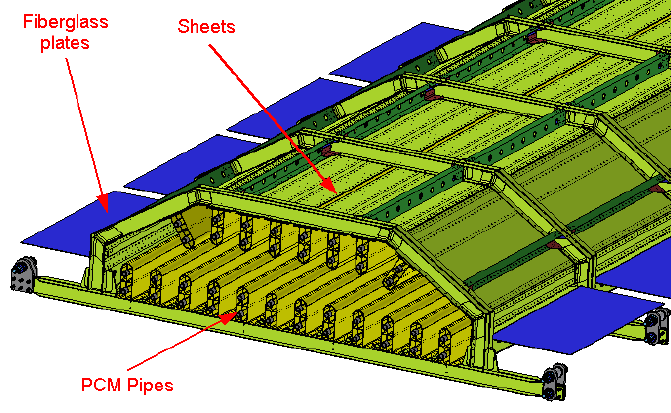
Figure 5: Position of sheets and PCM pipes in the roof.